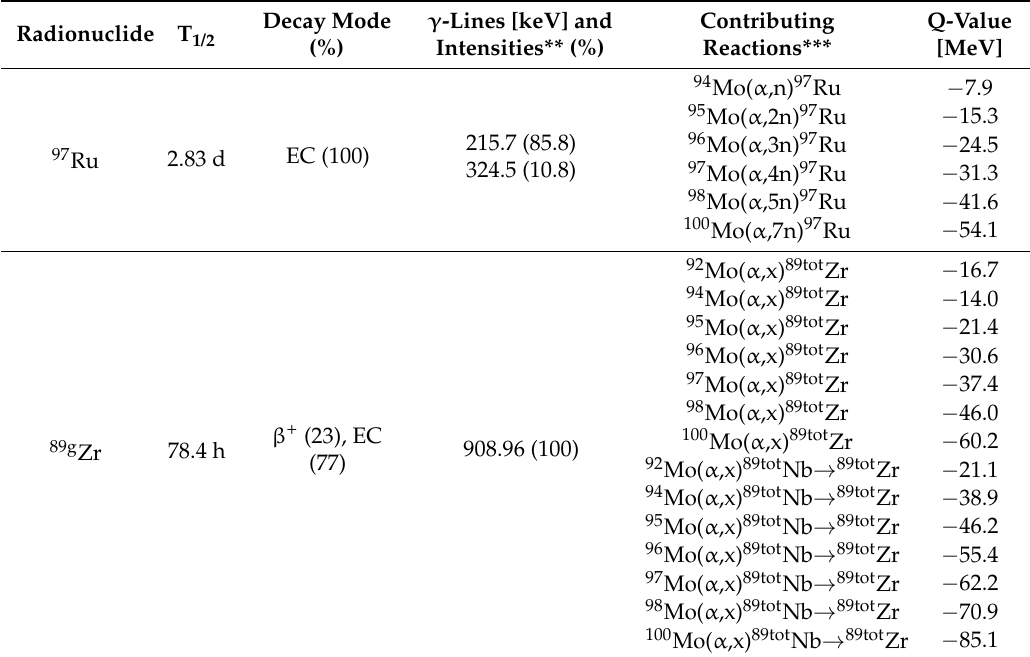
Table 1. Nuclear data [22] of 97 Ru and observed radionuclidic contaminants as well as reactions contributing to their formation during the irradiation of nat Mo